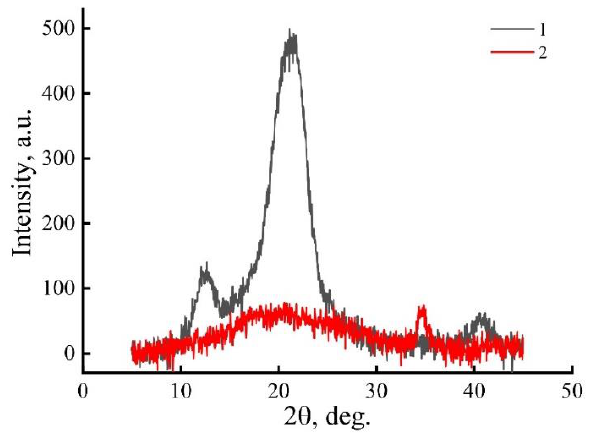
Figure 11. Equatorial (1) and meridional (2) diffraction patterns of fibers spun from 7% solutions of flax noils cellulose in NMMO (transmission mode).